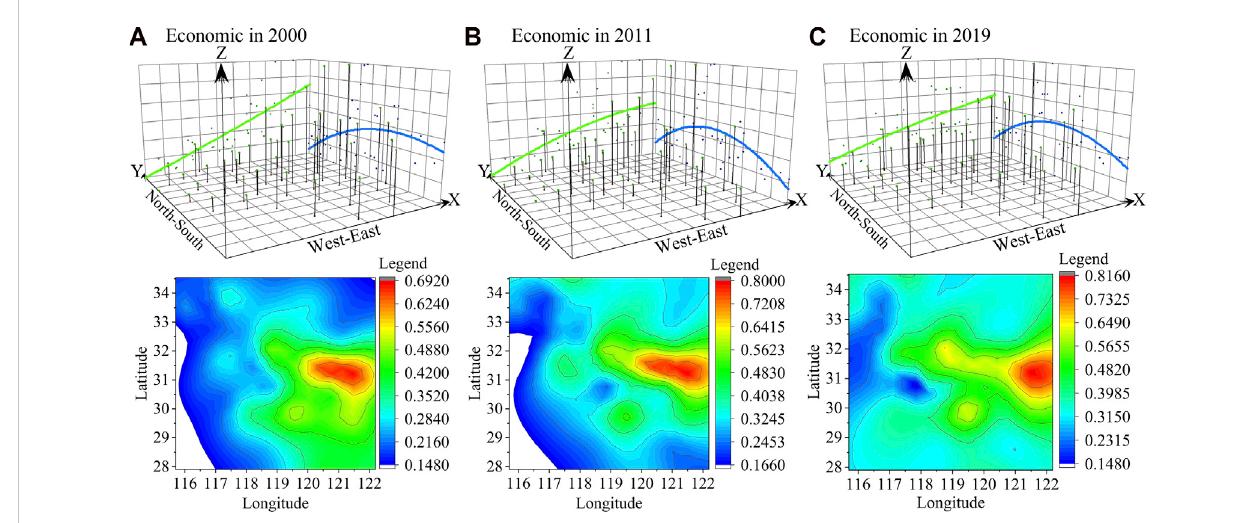
FIGURE 4 Spatial distribution pattern of economic agglomeration index in the YRD from 2000 to